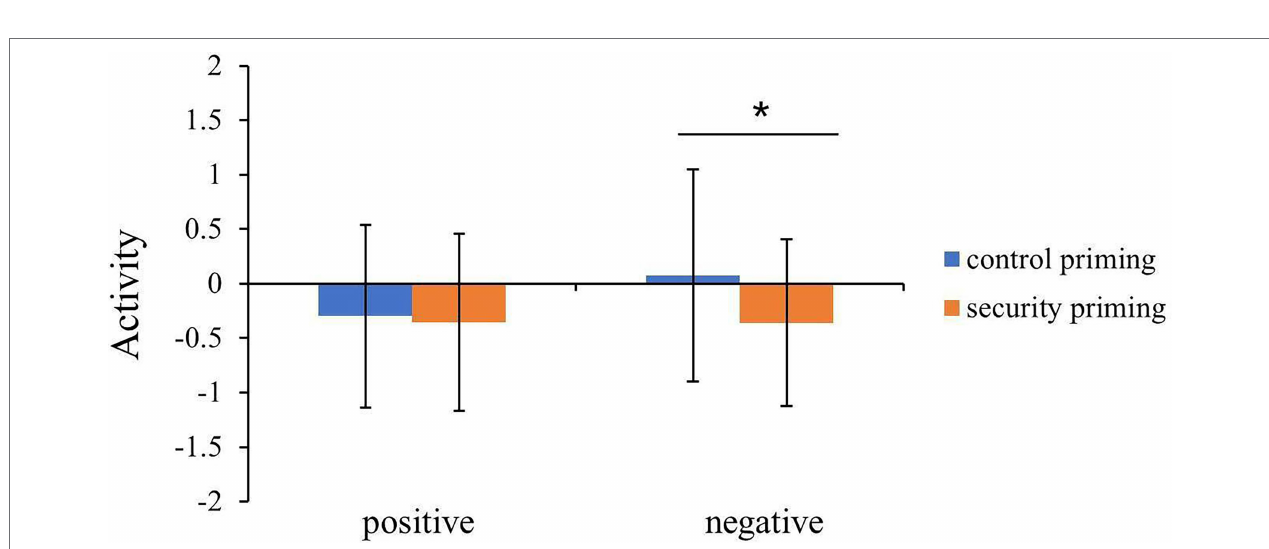
FIGURE 2 | Extracted beta values from left amygdala showed the activation pattern between control priming and attachment security priming conditions. Error bars indicate the standard deviation of means (* p <